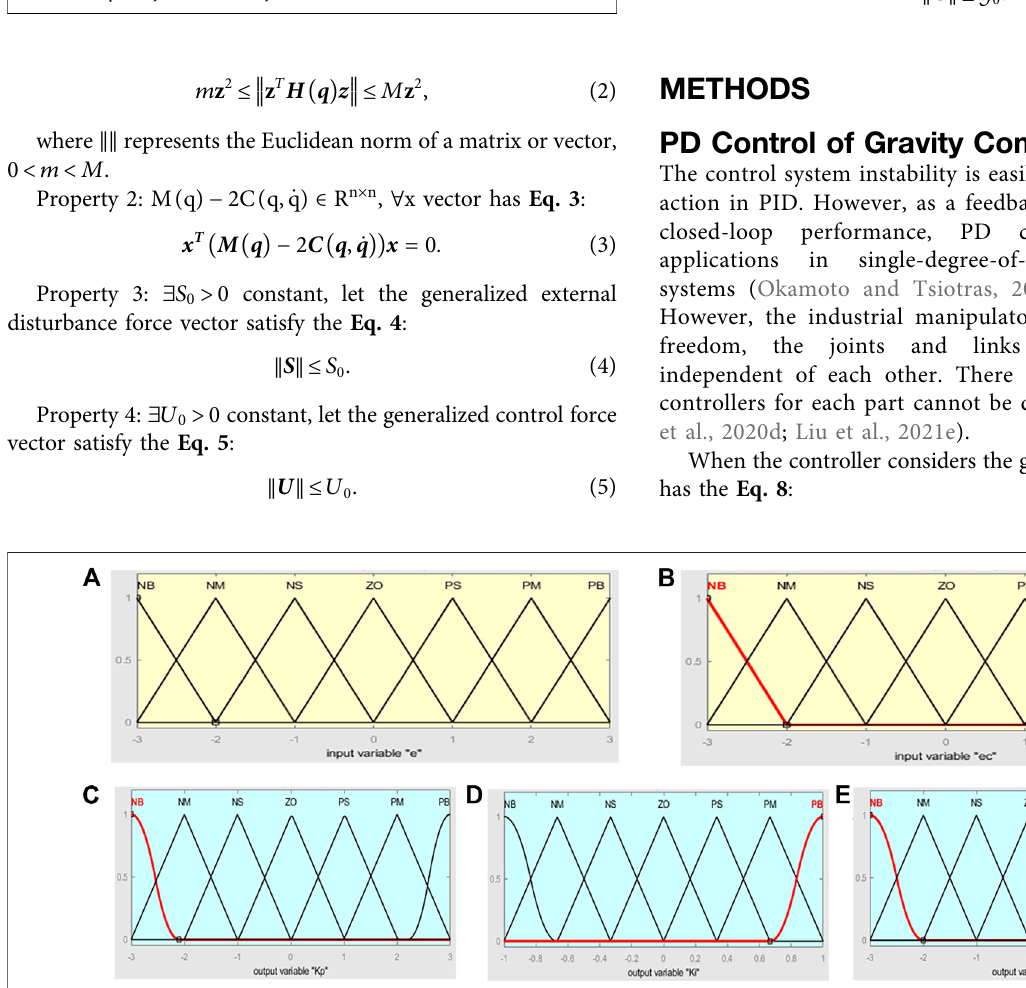
FIGURE 3 | Fuzzy PID control system.